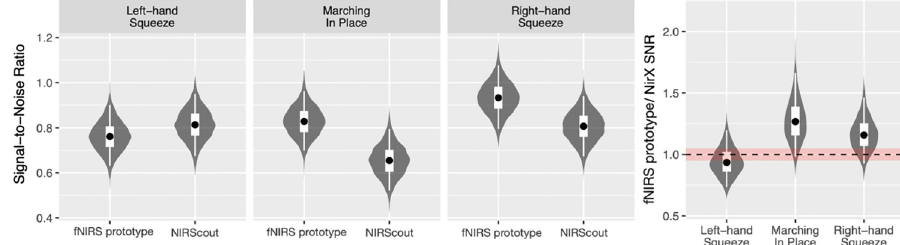
Fig 4. Posterior distributions of CNR ratios between fNIRS systems. Posterior distributions for CNR in each task for each fNIRS system as well as the CNR difference ratio between fNIRS systems (right-most pane)—i.e., the CNR of an fNIRS prototype system divided by the CNR of the NIRScout system (with 1 meaning no differences). Grey violins depict the mirrored density-smoothed distributions, black dots depict the posterior median, thick white rectangles depict the 50% credible interval and thin white lines depict the 95% credible interval. Red bands in the ratio plot depict the range of ratios from 0.95 to 1.05.